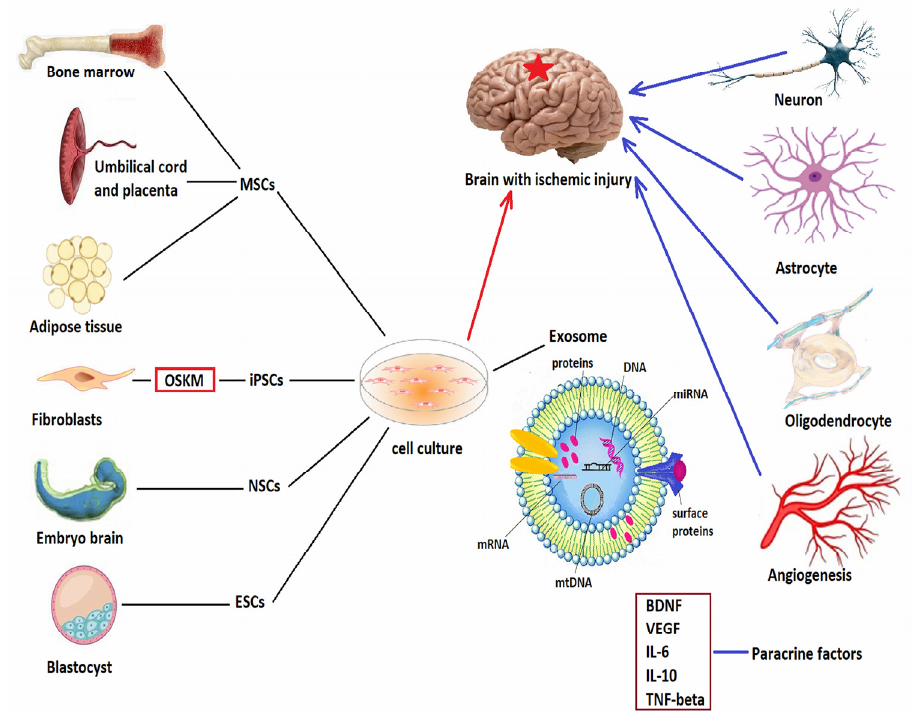
Figure 2. Embryonic pluripotent stem cells (ESCs) are derived from the inner layer of the blastocyst, Neural multipotent stem cells are obtained from human fetal cortex, mesencephalon, or spinal cord. Mesenchymal multipotent stem cells can be harvested from bone marrow, umbilical cord and pla- centa, or from adipose tissue. There is also the possibility of obtaining induced pluripotent stem cells (iPSCs) via transduction of the four OSKM genes: octamer-binding transcription factor 4 (Oct4), sex-determining region Y-box 2, (Sox2), the Krupellike factor 4 (Klf4), and the avian myelocytoma- tosis viral oncogene homolog (c-myc). Once harvested, stem cells are cultured in special culture medium, where they release exosomes carrying proteins, DNA, messenger RNA (mRNA), mi- croRNAs (miRNA), and mitochondrial DNA (mtDNA). Once delivered to the brain by various routes, they differentiate into neurons, astrocytes, and oligodendrocytes, and release various growth factors (such as brain derived neurotrophic factor-BDNF or vascular endothelial growth factor-VEGF) and anti-inflammatory cytokines (interleukins IL-6, IL-10, or tumor necrosis factor β ), which modulate neuroinflammation and promote angiogenesis, neurogenesis, neural differentia- tion, and synaptogenesis.